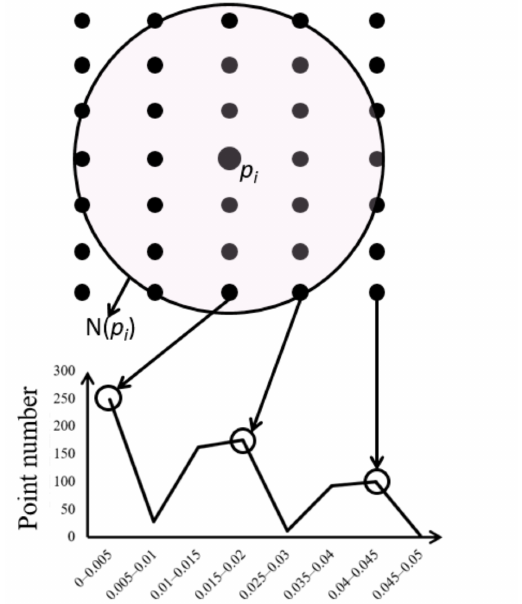
Figure 4. Example of the histogram of ∆ θ ij values with ∆ set as 0.005 ◦ . There are three large inflection points in this example. In addition to the range of (0 ◦ , 0.005 ◦ ), the interval with the largest number of points is the one most likely to correspond to the adjacent vertical scanning line of p i . Thus, the mean value of ∆ θ ij in (0.015 ◦ , 0.02 ◦ ) is calculated as the horizontal angular resolution for this